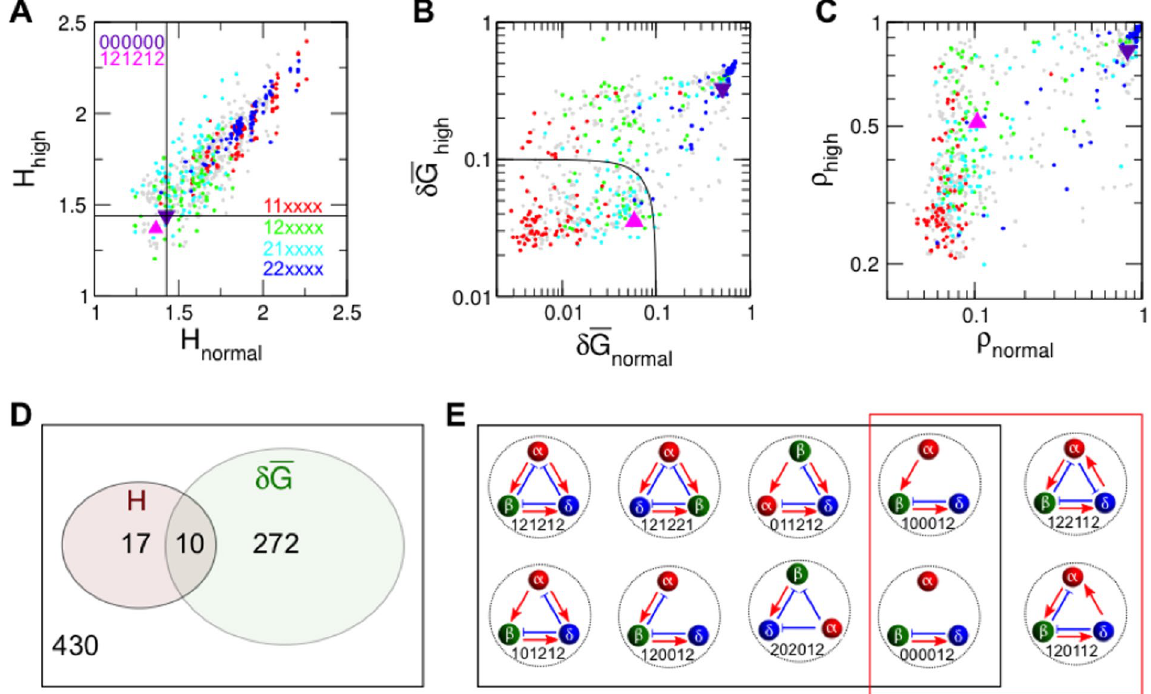
Figure 2. Efficient hormone consumption and glucose regulation. ( A ) Hormone consumption, ≡ + α β H H H , of 729 networks under normal ( I = 0) and high ( I = 2 G 0 ) glucose conditions: networks 121212 (pink triangle, native interaction between islet cells), 000000 (purple inverted triangle, no interaction), 11xxxx (red circles, mutual activation between α and β cells), 12xxxx (green circles, native asymmetric interaction), 21xxxx (cyan circles, inverse asymmetric interaction), 22xxxx (blue circles, mutual inhibition), and the others (gray circles). Network 000000 is located at the crossing of vertical and horizontal black lines. ( B ) Temporal fluctuations of glucose, normalized according to the absolute glucose concentration, δ δ ≡ G G G / , under normal/high glucose conditions. Black lines separate the networks that produce small glucose fluctuations ( δ δ + < . G G 0 1 normal2 high2 2 ). ( C ) Degree of synchronization between islets under normal/high glucose conditions. The time-averaged synchronization index, ρ = 1/0, represents perfect synchronization/independence between islets. ( D ) Ten effective networks satisfy the two criteria of minimal hormone consumption and small glucose fluctuations inside the black lines in ( A ) and ( B ). ( E ) Topologies of the ten effective networks with their annotations. Positive/negative interactions are represented by red/blue bar-headed arrows, respectively. A black rectangle groups subsets and transformations of network 121212, while a red rectangle groups subsets of network 122112. To highlight this, networks are plotted with fixed arrow positions, not cell